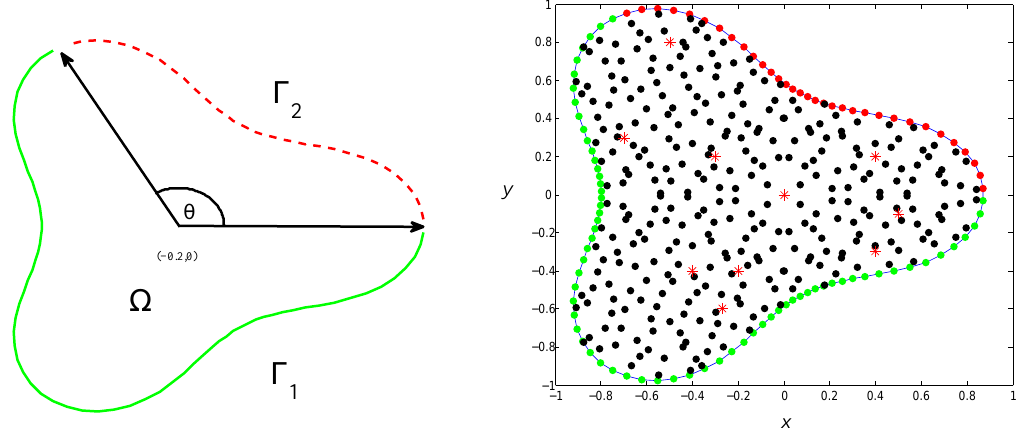
Figure 7. Model domain for Test Problem